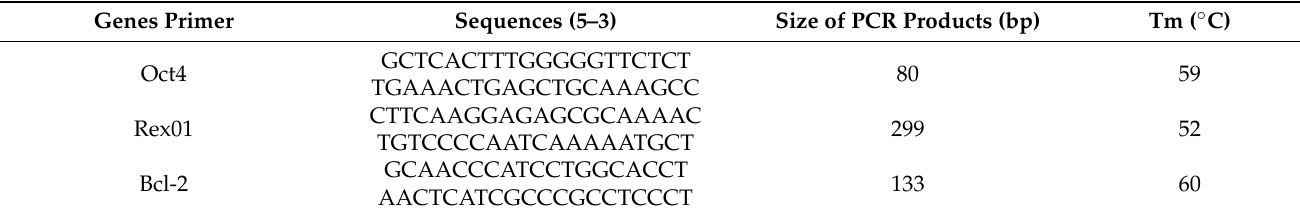
Table 1. Primers sequences and conditions for